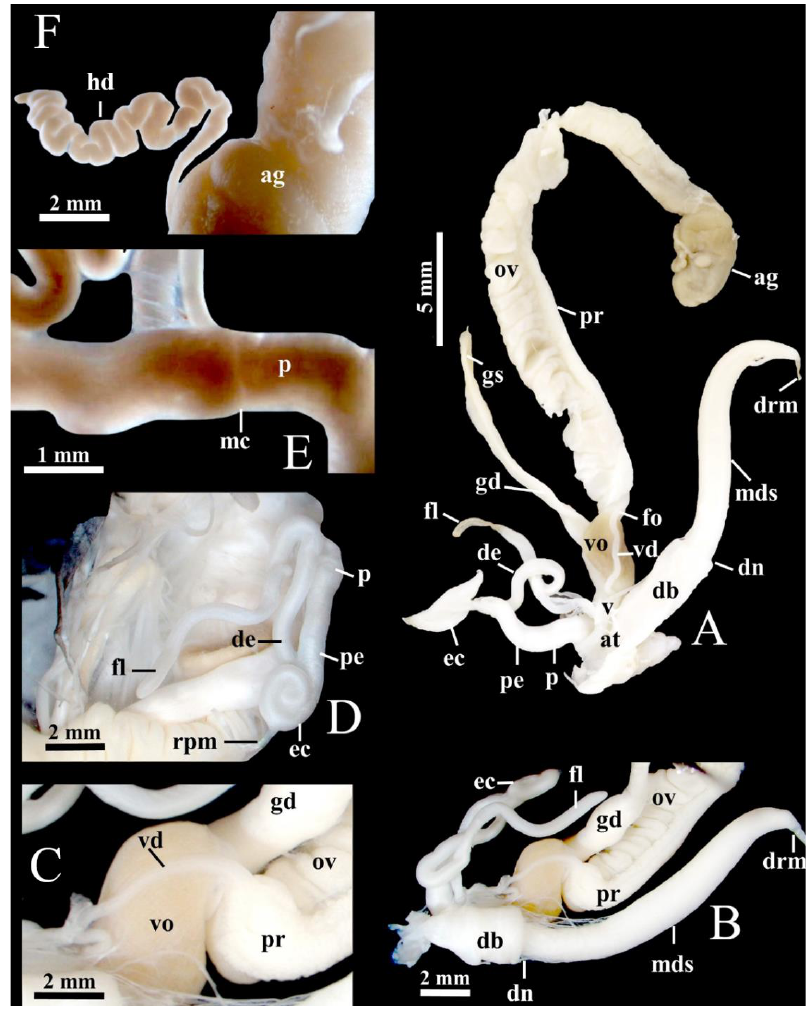
Figure 5. Reproductive system of Macrochlamys indica collected from My Garden nursery, Al-Ahsaa. ( A ) general view of genitalia; ( B ) enlarged view of proximal portion of the genitalia; ( C ) magnified view of prostate gland, vas deferens, and vaginoviducal capsule; ( D ) enlarged view of epiphallus and epiphallic caecum; ( E ) magnified view of penis; ( F ) hermaphrodite duct and albumen gland. Abbreviations: ag, albumen gland; at, genital atrium; db, dart bag; de, distal epiphallus; dn, dart neck; drm, dart retractor muscle; ec, epiphallic caecum; fl, flagellum; fo, free oviduct; gd, gametolytic duct; gs, gametolytic sac; hd, hermaphrodite duct; mc, median constriction; mds, median dart shaft; ov, oviducal channel; p, penis; pe, proximal epiphallus; pr, prostate gland; rpm, penial retractor muscle; vd, vas deferens; vo, vaginoviducal.